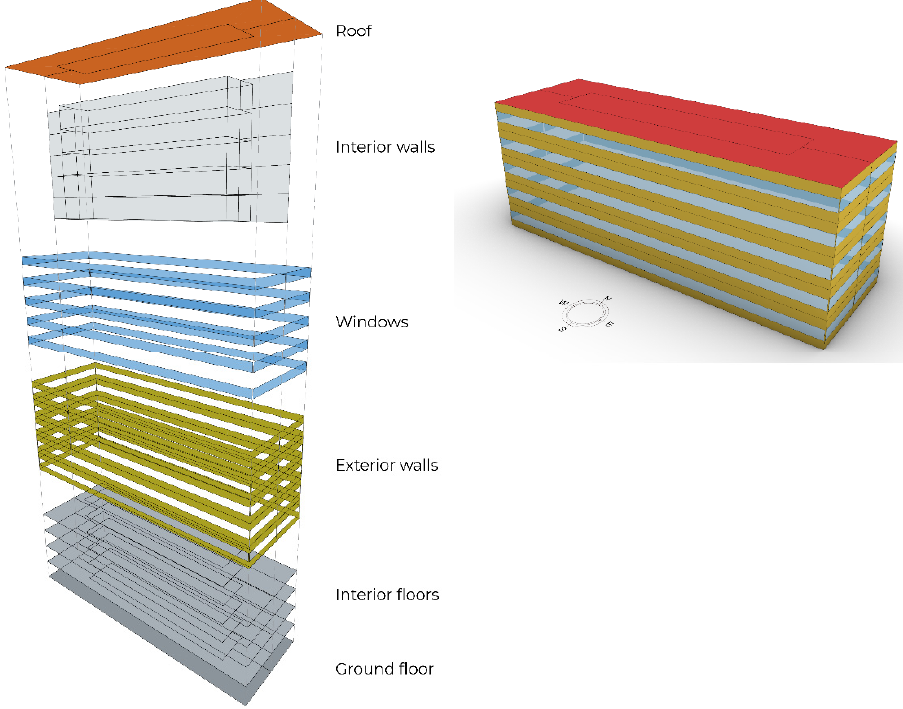
Figure 1. Typical office building. ( Left ): Main building components. ( Right) : Whole building. The exterior walls of the building were modeled from concrete and autoclaved aerated blocks (both with minimum and maximum windows), which resulted in 4 opposite options: a concrete-block-based side with minimal windows (CB MinWin ); a concrete-block-based side with maximal windows (CB MaxWin ); an autoclaved aerated-block-based side with minimal windows (AAB MinWin ); and an autoclaved aerated-block-based side with maximal windows (AAB MaxWin ). These alternatives were based on the supposition that: (i) there is a significant difference in OE ranks between a building with minimal windows and one with maximal windows, and (ii) there is a significant difference in P&C damage between exterior concrete-block-based and autoclaved aerated-block-based walls. This is because, in the hot Mediterranean climate in Tel Aviv, maximal windows can result in higher less P&R damage than concrete blocks [15].